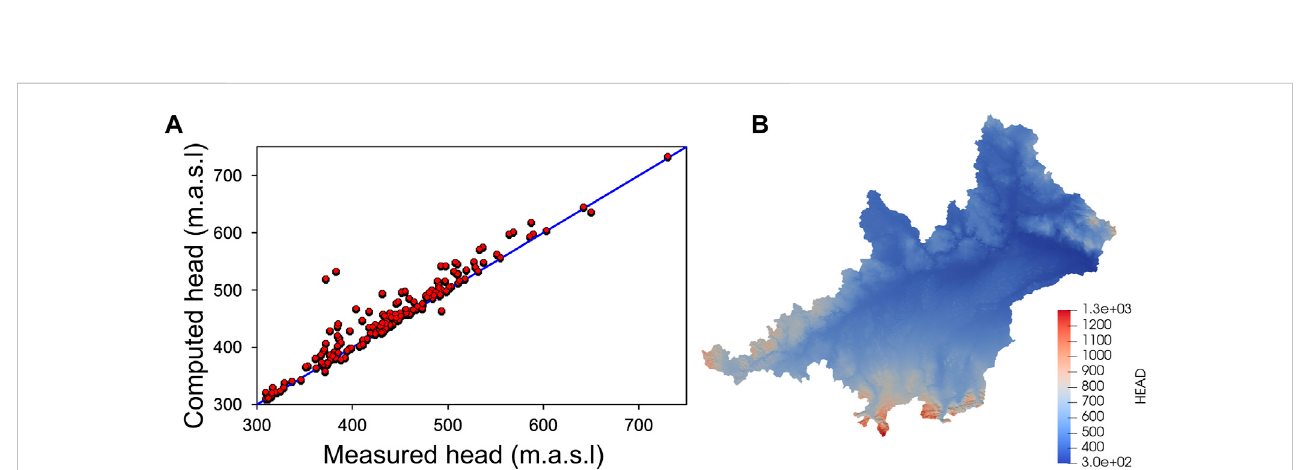
FIGURE 13 (A) Fittingbetweenmeasuredandcomputedsteadystatepiezometricheads.ThesimulationisundertakenusingtheKvaluescalibratedwiththemethod M2. In M2 the model is calibrated by fi tting the variance of the measured and computed piezometric heads; (B) Steady state piezometric head distribution when K values obtained with method M2 are